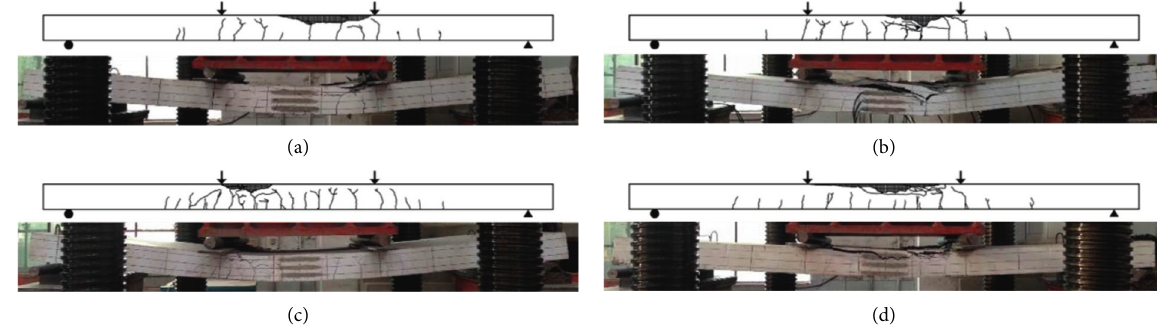
Figure 8: Deformation and crack distribution in flexural failing specimens: (a) HSC1-1; (b) HSC1-2; (c) HSC1-3; (d) HSC1-5.